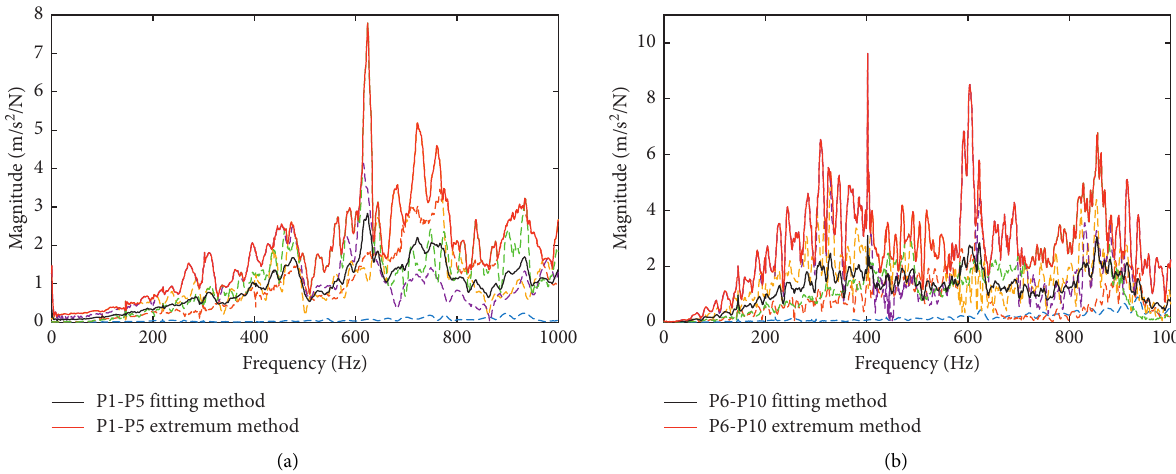
Figure 8: Comparison between the fitting and extremum methods of different regions. (a) Regions 1–5 (P1-P5). (b) Regions 6–10 (P6-P10).